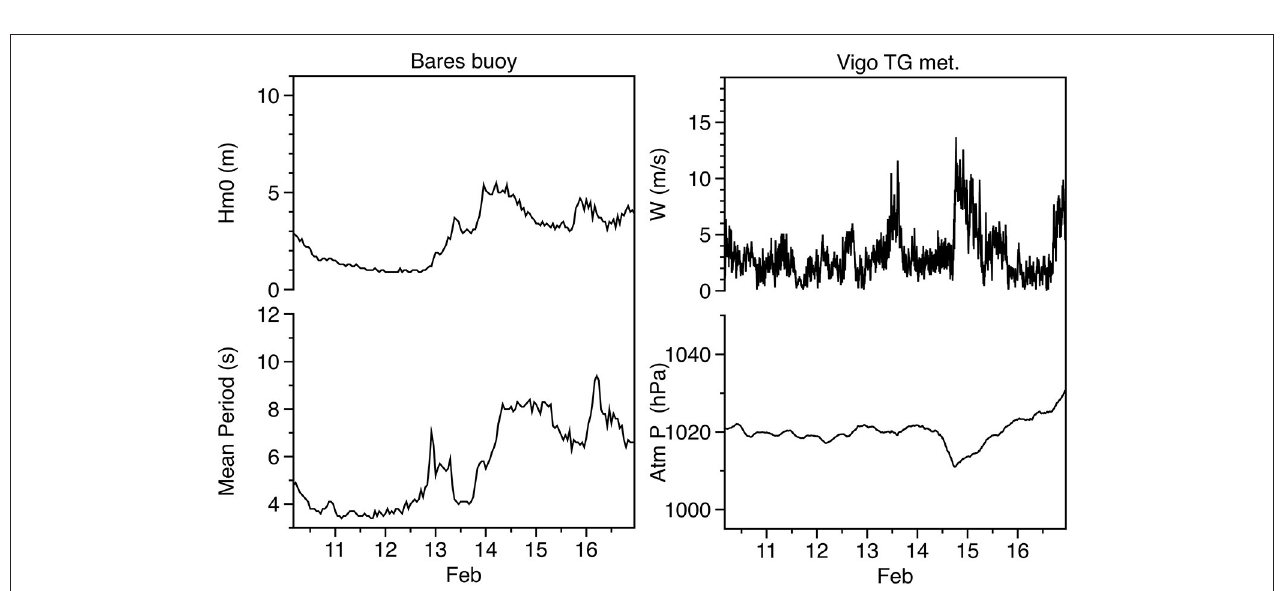
FIGURE 14 | Left: significant wave height ( H m0 ) and mean period ( T m ) recorded by Bares open waters buoy during the oscillations event of February 2015; right: mean wind velocity and atmospheric pressure recorded by the meteorological sensors of Vigo tide gauge for the same period (1-min sampling resolution).